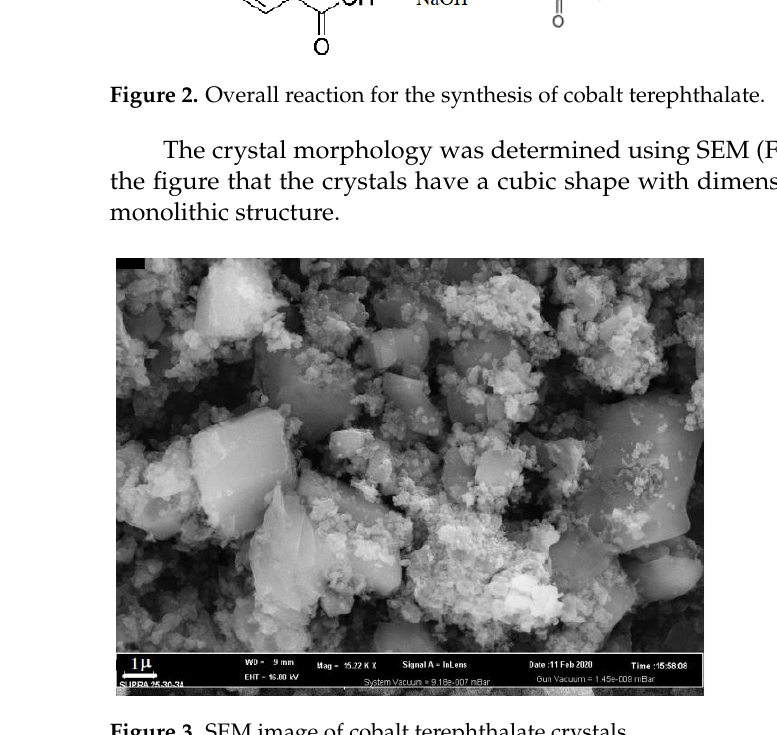
Figure 3. SEM image of cobalt terephthalate crystals.